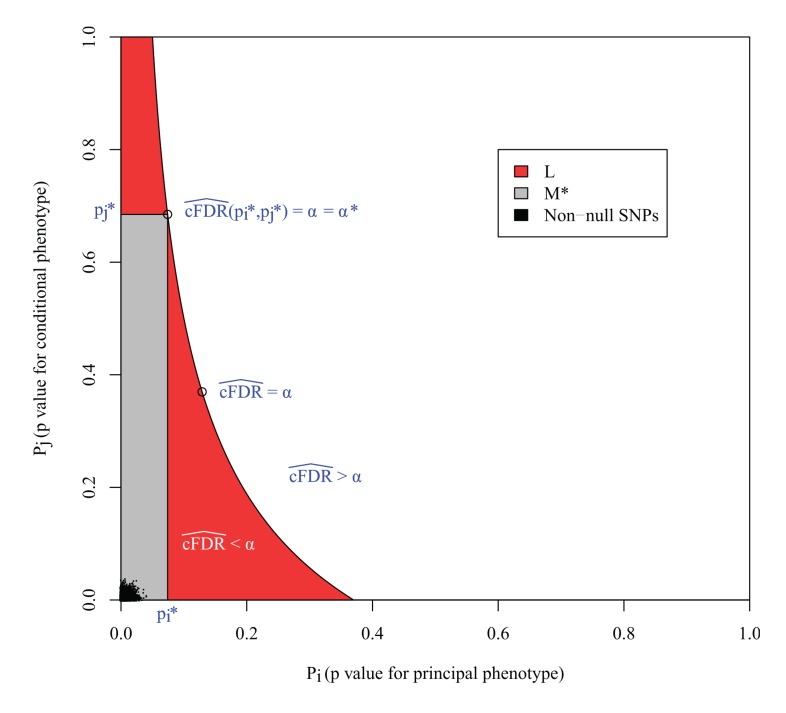

L is the locus of a set of points with cFDR^=α.The FDR is the ratio of null SNPs to total SNPs in L. If all the non-null SNPs were concentrated in the lower left corner, then the number of non-null SNPs in L would be equal to that in any individual rectangle with vertices at the origin and on L, but the number of null SNPs would be greater, meaning that the expected FDR of all SNPs in L would be greater than α. M
* is the largest rectangle by area contained within L. The false discovery rate within M
* is less than α
*, the value of cFDR^ at the upper right vertex, which is usually equal to α, as in this case. The FDR of L is bounded by α
*
v(L)/v(M), where v(L) and v(M
*) are the expected number of null SNPs in L and M
* respectively (S1 Text, section B).